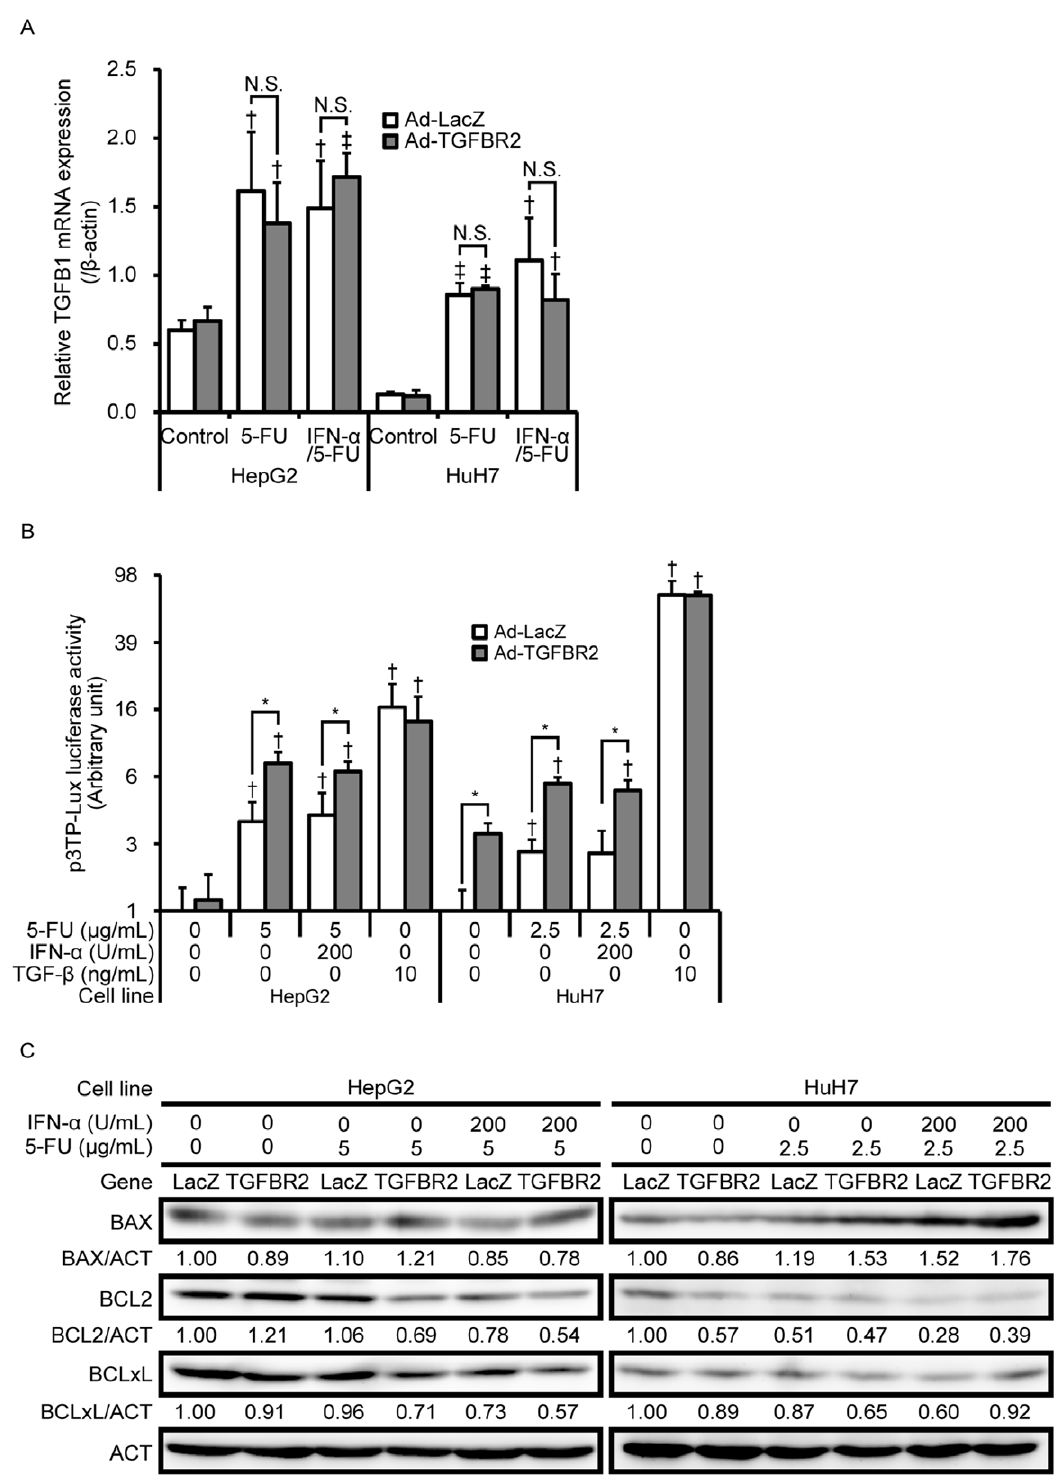
Figure 4. Effects of TGFBR2 on 5-FU- and IFN- a /5-FU-induced TGF- b signaling pathway. (A) 5-FU-induced TGFB1 mRNA expression normalized to b -actin. Data are expressed as mean 6 standard deviation (SD) ( n= 3). Statistical significance was determined using Student’s t -test. { P , 0.05 and { P , 0.001 compared to control. N.S., not significant. (B) Luciferase reporter assay for TGF- b signaling activation. Data are expressed as mean 6 SD ( n= 3). Recombinant TGF- b was used as a positive control. The Y-axis is expressed as a logarithmic scale. (C) Western blot analysis of BAX, BCL-2, and BCL-xL in 5-FU and IFN- a /5-FU treatment with or without TGFBR2 overexpression. Each band was quantified by Image J software and normalized to actin.